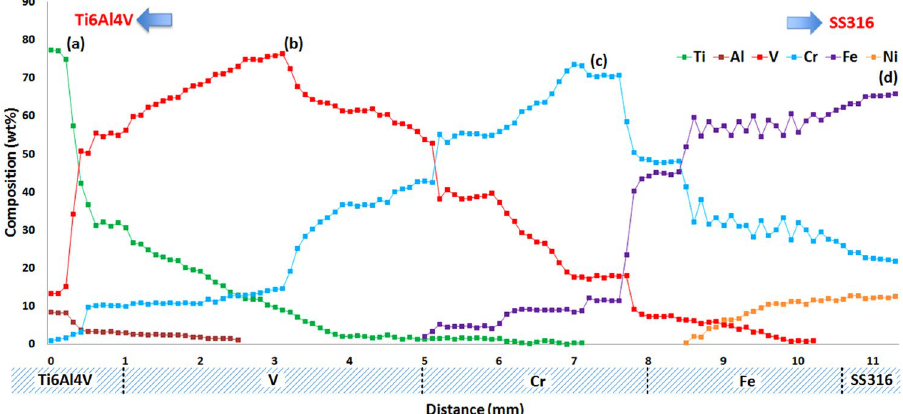
Figure 8. The EDS point test result for composition curve.